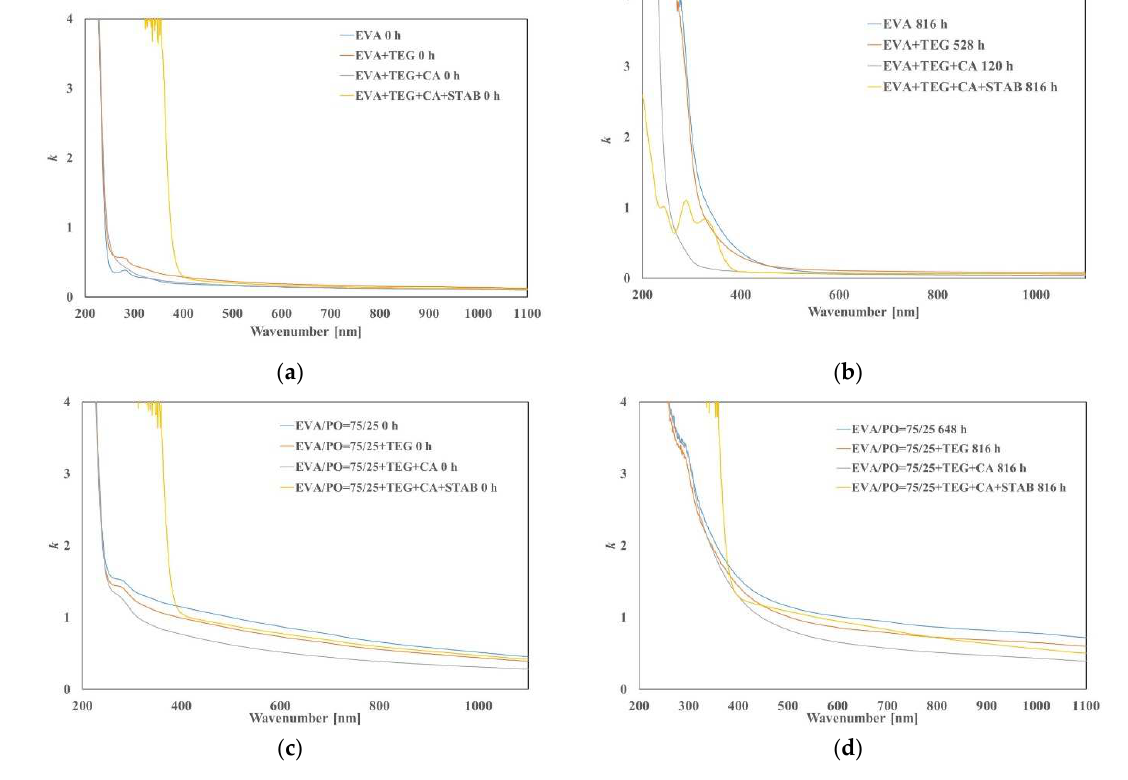
Figure 6. Linear attenuation coefficient ( k ) of EVA ( a ) before exposure and ( b ) at maximum UVB exposure time and of EVA/PO = 75/25 wt.% ( c ) before exposure and ( d ) at maximum UVB exposure time with and without an adhesion promoter (TEG), a crosslinking agent (CA) and stabilizers (STAB).